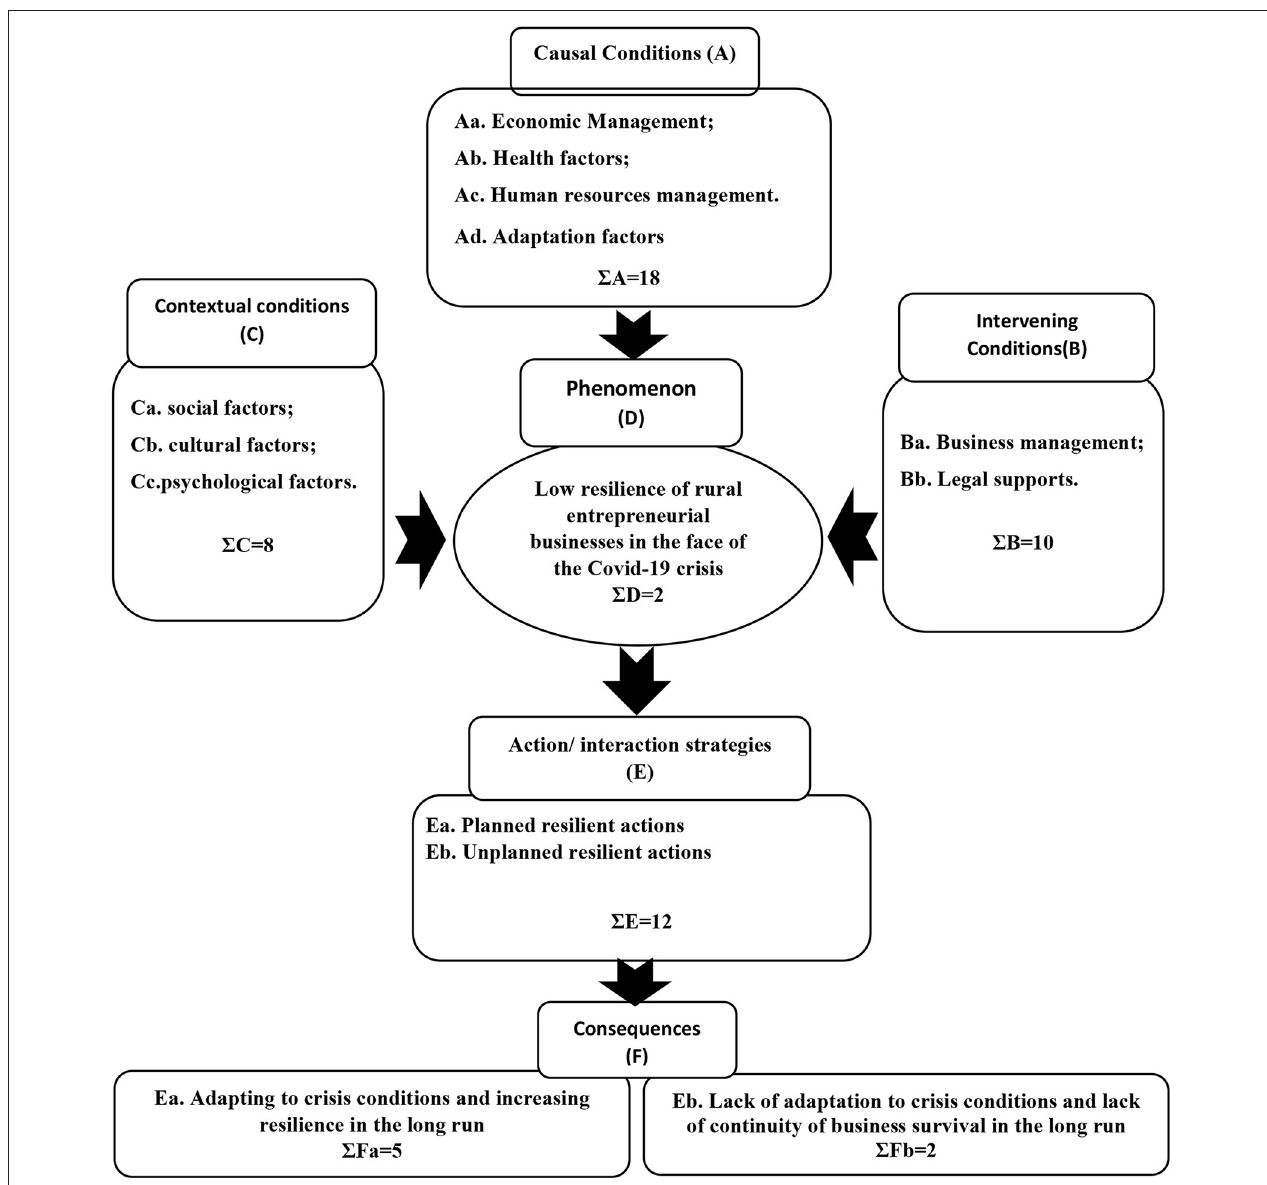
FIGURE 3 | Paradigm model of the resilience of rural entrepreneurial businesses in the face of the COVID-19